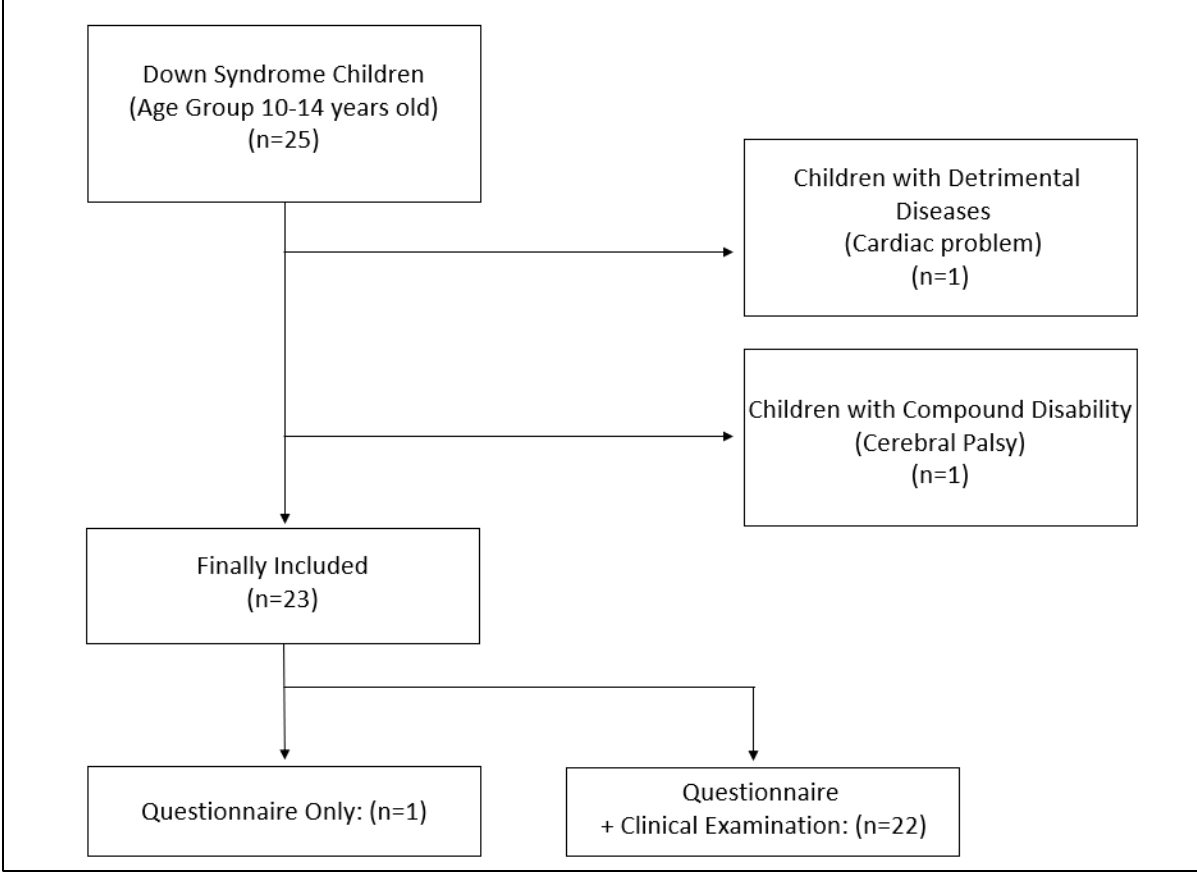
Figure 1. Flowchart showing the number of Down syndrome children participating in the study. (+) Questionnaire and Clinical Examination.